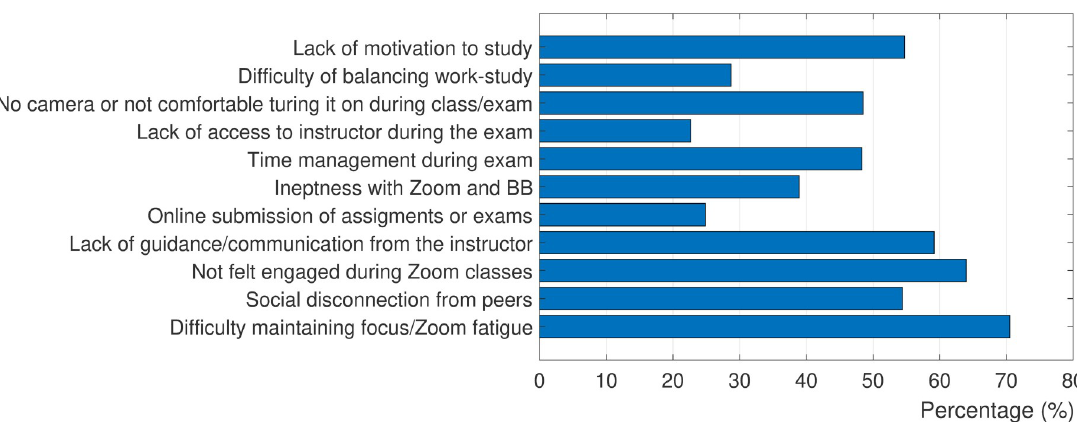
Fig 3. Prevalence of challenges students encountered during online instruction in Spring